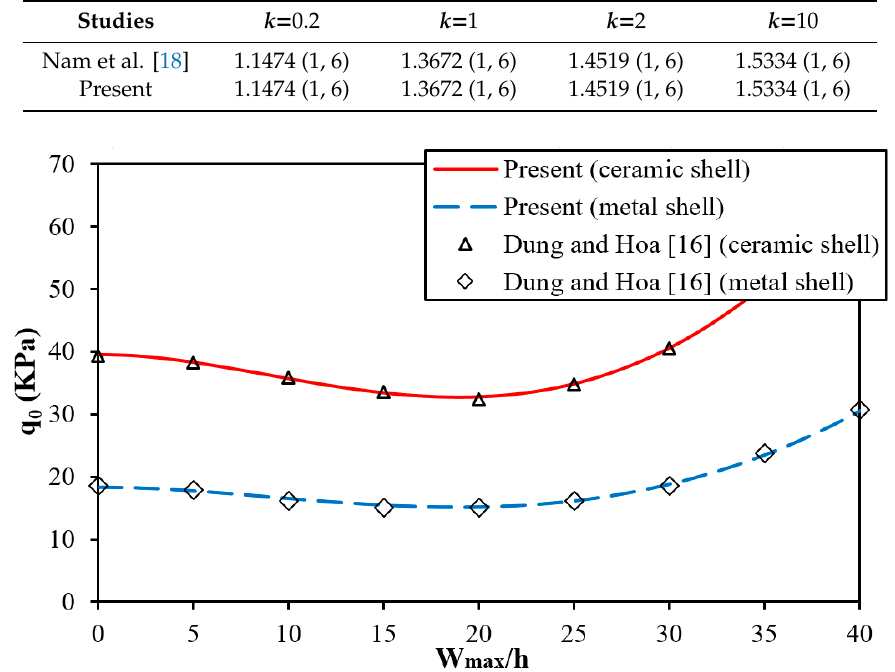
Figure 2. Comparison of postbuckling curves of ceramic and metal cylindrical shells and the results of Dung and Hoa [16] ( h = 0.305 mm, R = 60.643 mm, L = 387.35 mm, ν = 0.3, and E = 151 GPa for a ceramic shell, and E = 70 GPa for a metal